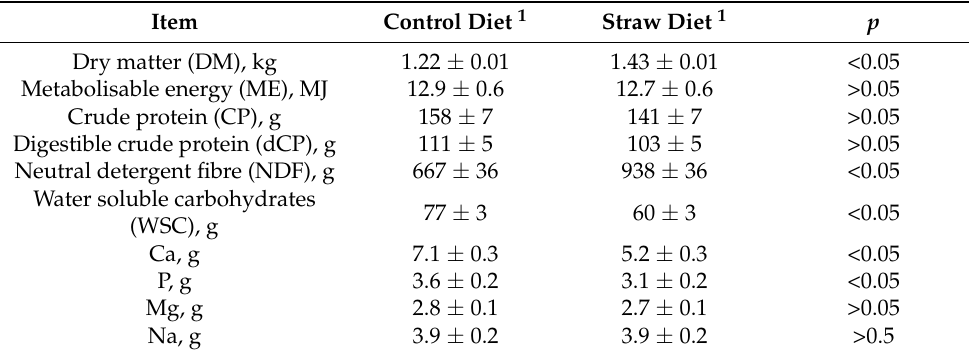
Table 2. Dry matter, energy and nutrient allowances 1 of the control diet (CON, (grass haylage only)) and the straw diet (S, 50% grass haylage and 50% wheat straw on a dry matter basis) per 100 kg BW and day (LSmeans ± SE) offered to six horses in a 2 × 21-day cross-over design. The diets were fed on metabolic body weight basis and allowances rounded to the nearest 10